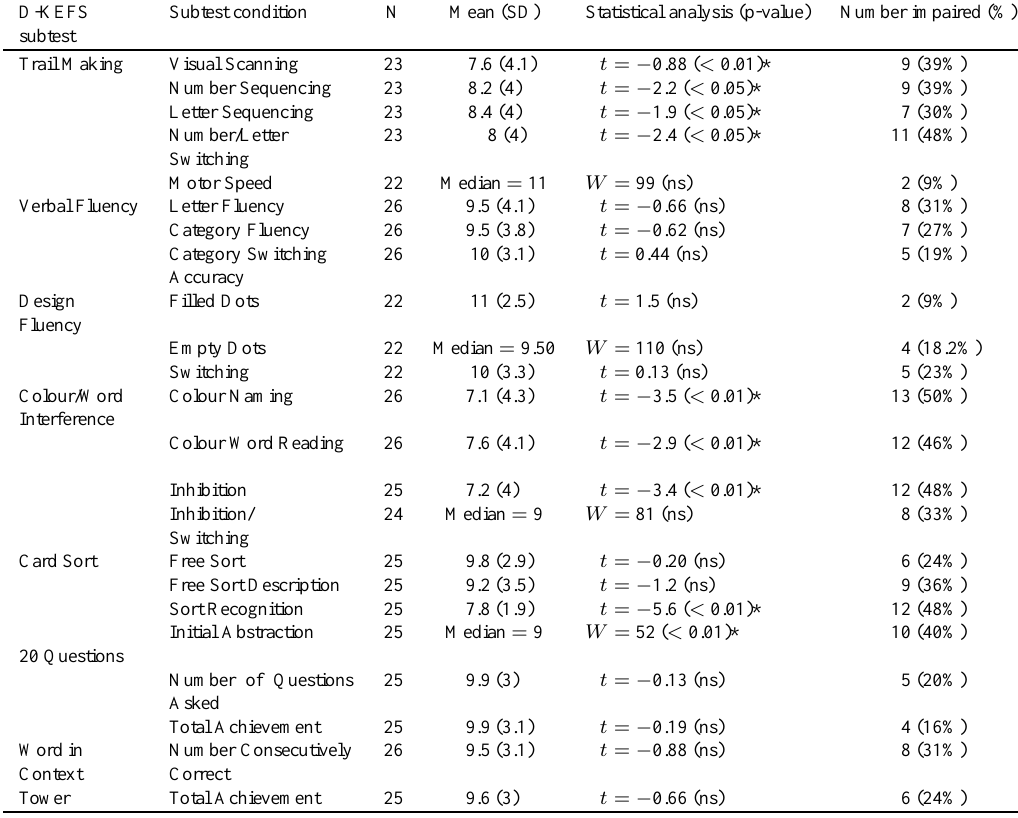
Table 3 Executive functioning of SCA6 group and comparison with control data